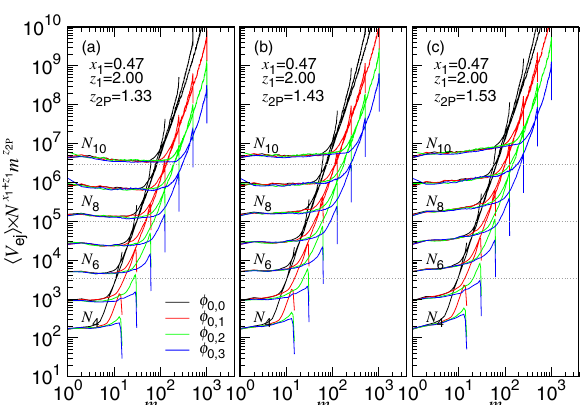
0.57 . V ej N x 1 + z 1 m − z 1 vs. m , by setting ( a ) x 1 0.37 , ( b ) x 1 0.47 , and ( c ) x 1 = � � × = = 2 i is indicated near the bottom of the figure close to the = 0.3 2 − j . = ×